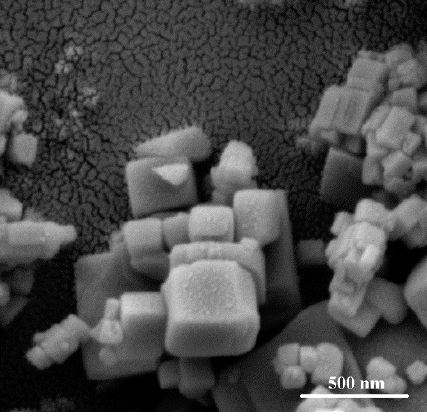
Figure 1. SEM images of the potassium sodium niobate ceramic (KNN) ceramic powders prepared by conventional solid-state calcination method.